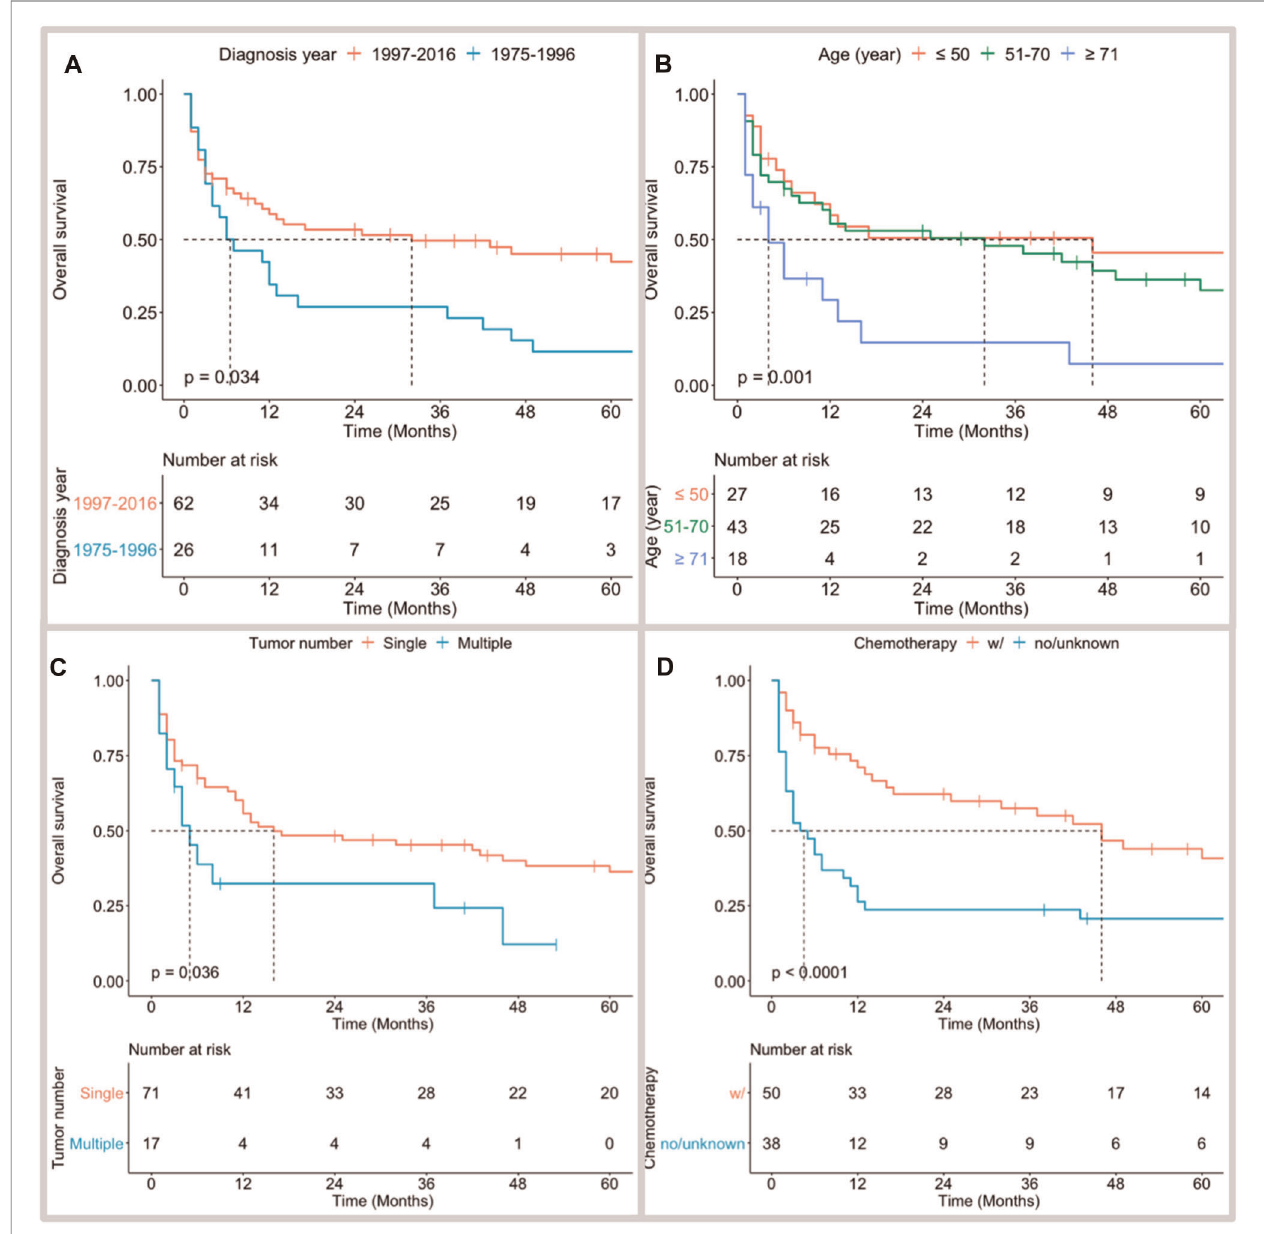
FIGURE 2 | Kaplan – Meieroverall survival curves of PBSL patients strati fi ed by diagnosisyear ( A ), age at diagnosis ( B ), tumor number ( C ), and use of chemotherapy ( D